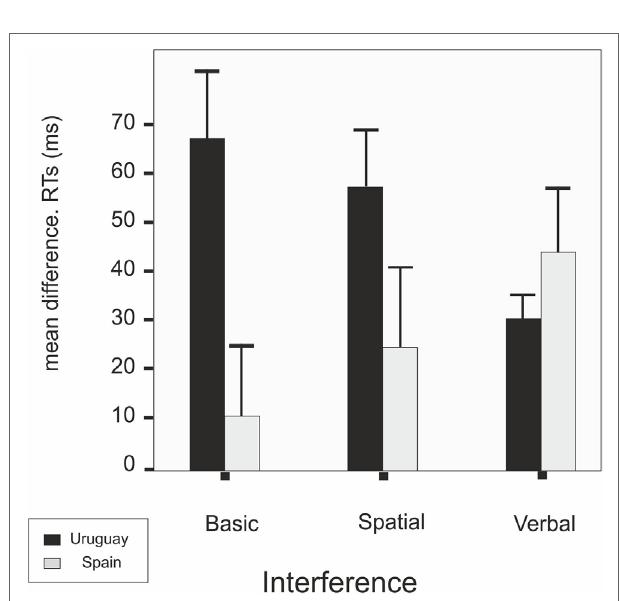
FigUre 7 | Category advantage (difference between cross-category and within category RT means) for the three interference conditions by group. Error bars represent SEM.